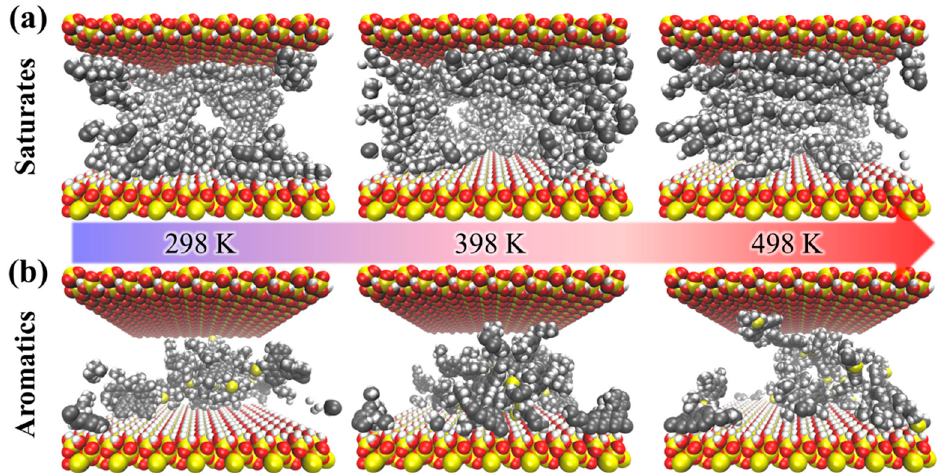
Figure 5. Snapshots of final configurations of ( a ) saturates, ( b ) aromatics in quartz nanopore at 298 K, 398 K, and 498 K, respectively.